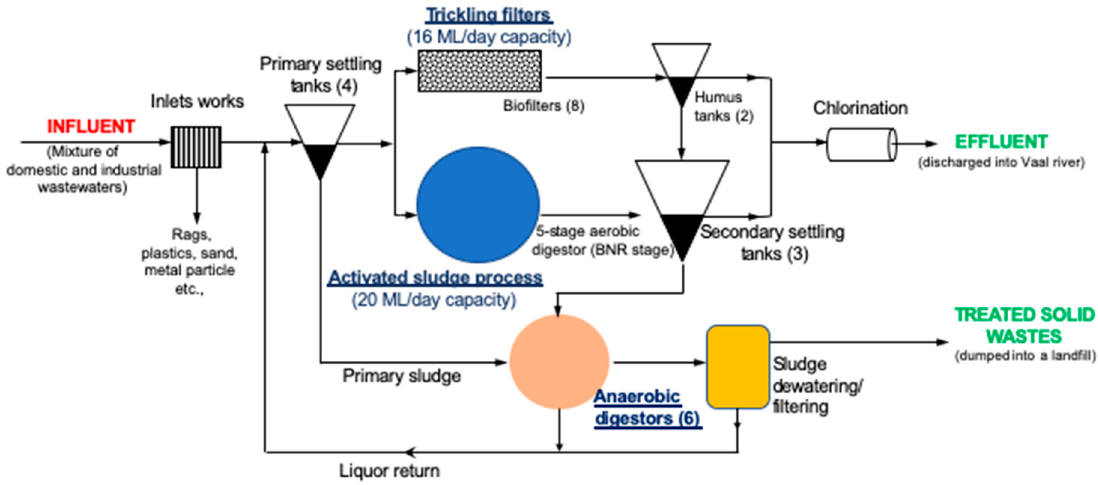
Figure 2. Flow diagram of the Leeuwkuil wastewater treatment plant (WWTP) showing stages of wastewater treatment, the capacity and the number of facilities within the plant (in brackets).